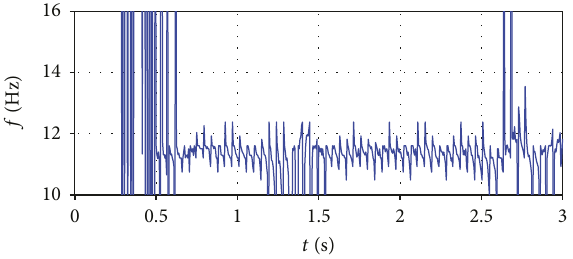
Figure 37: D3, decay test CWT, acceleration in the damaged node.